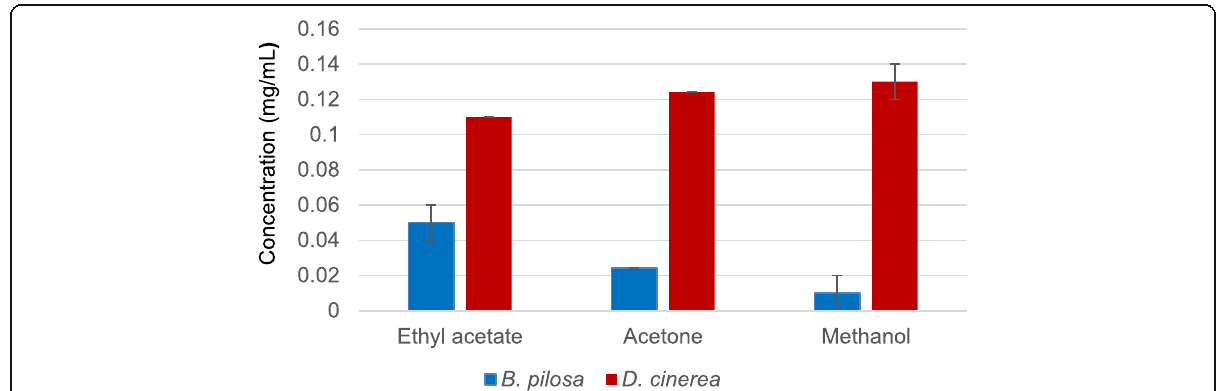
Fig. 4 The total phenolic content of leaf extracts of B. pilosa and D. cinerea extracted by ethyl acetate, acetone and methanol using the direct extraction